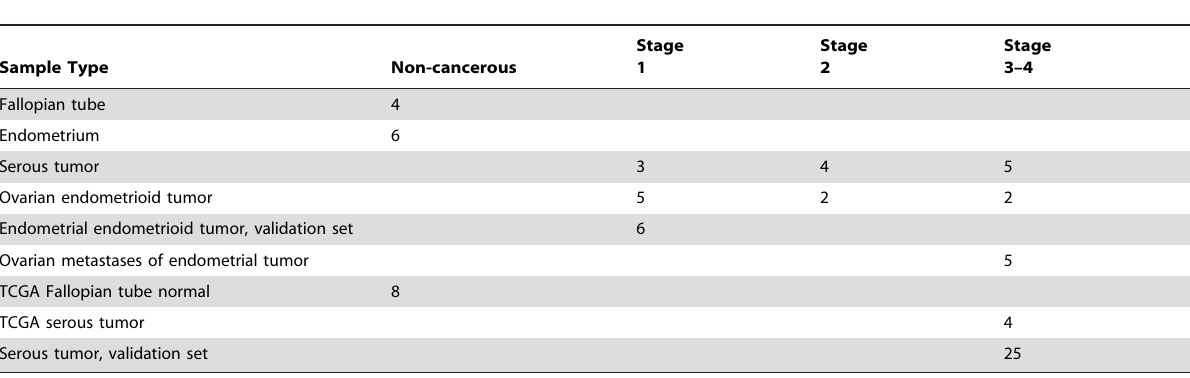
Table 1. Experimental samples for data clustering and validation